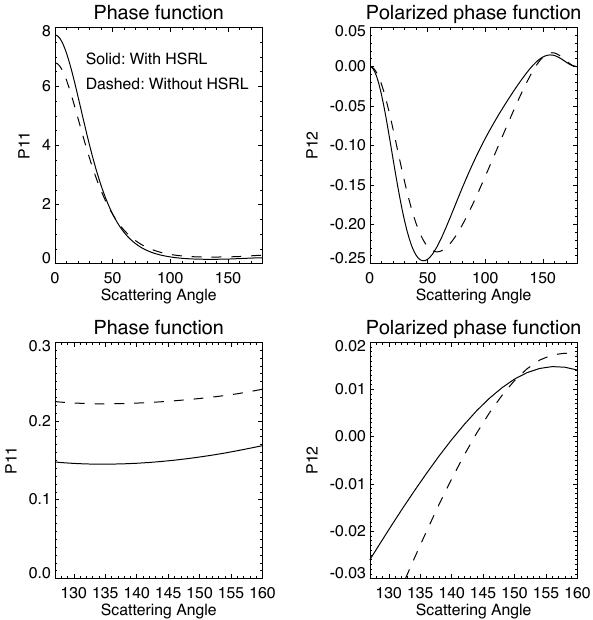
Fig. 7. These plots show the phase functions at 532nm of the fine mode aerosols for the segment in Fig. 5. Successful optimization re- sults using HSRL data are shown with solid lines, while unsuccess- ful optimization results performed without HSRL data have dashed lines. Plots in the left column are the total (unpolarized) phase func- tion, while plots in the right column are the polarized phase func- tion. Figures in the top and bottom rows show the same quantities, although the bottom rows have been zoomed to a scattering angle range that was observed by the RSP in that segment.